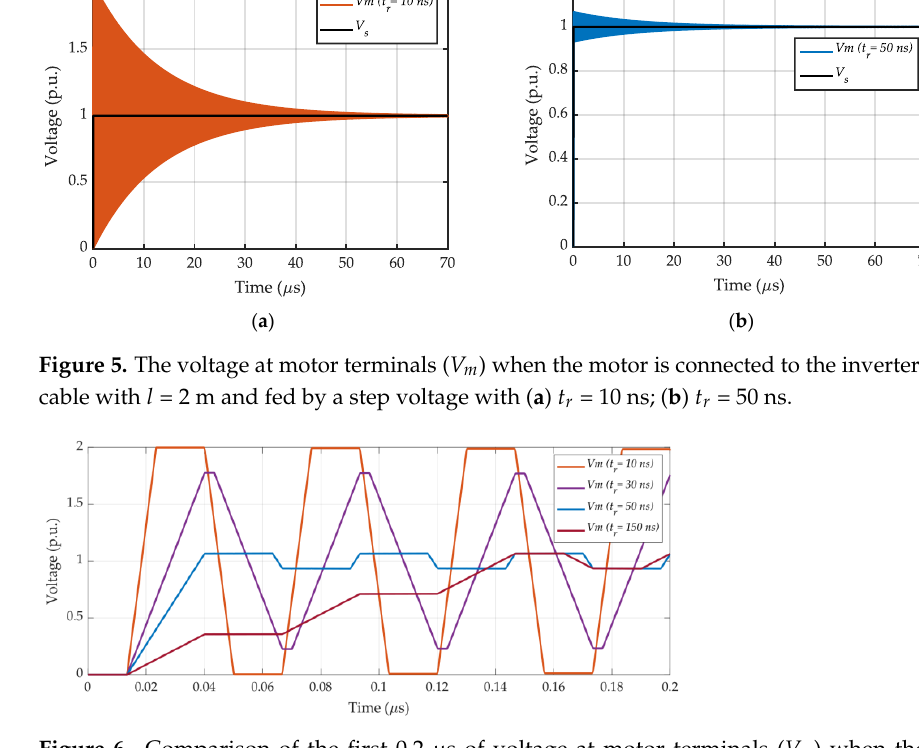
Figure 6. Comparison of the first 0.2 μs of voltage at motor terminals ( 𝑉 𝑚 ) when the motor is con- nected to the inverter through a cable with 𝑙 = 2 m and fed by a step voltage with various rise times.